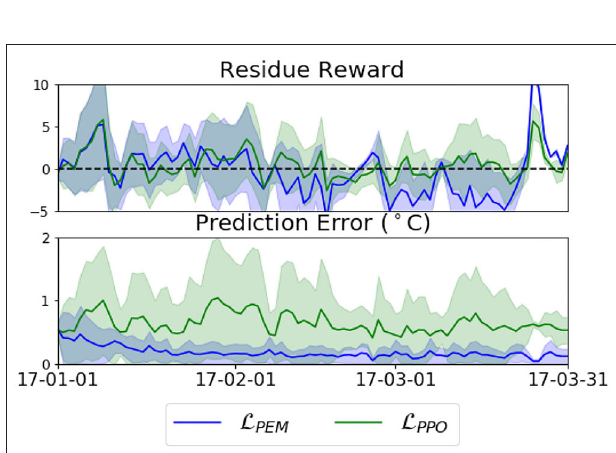
FIGURE 8 | Comparison of two approaches Policy Gradient ( L PPO ) vs. Adaptive MPC ( L PEM ); While optimizing L PEM resulted in consistently smaller prediction error, optimizing L PPO resulted in larger overall